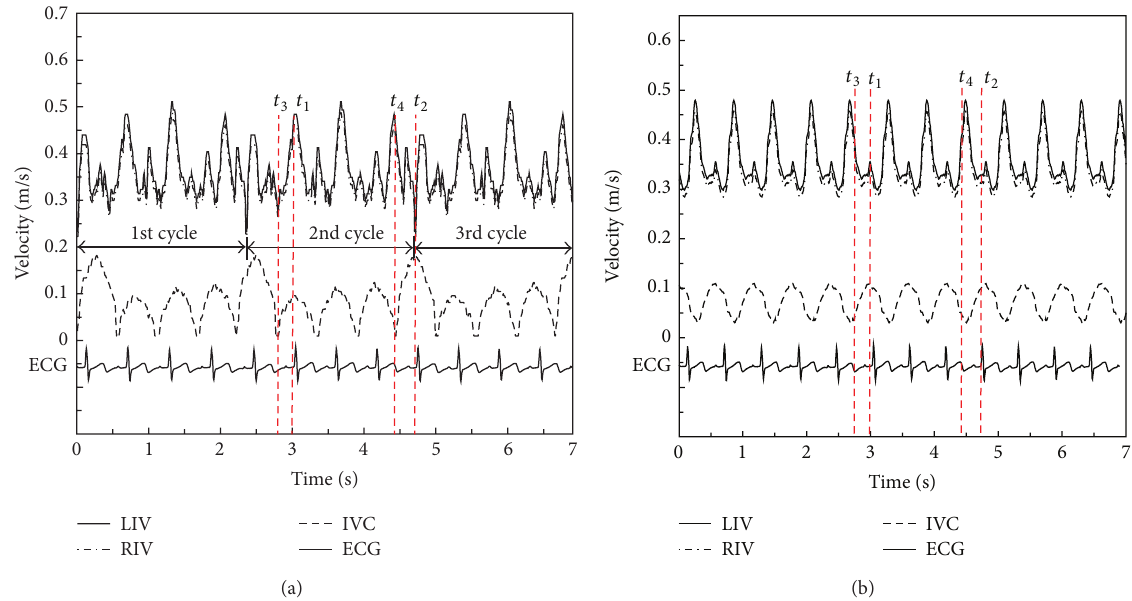
Figure6:Fourselectedtimestepsforhemodynamiccomparison( 𝑡 1 , 𝑡 2 , 𝑡 3 ,and 𝑡 4 ).(a)Inletvelocityconditionstakingrespirationintoaccount. (b) Inlet velocity conditions only including cardiac pulsatility (IVC: inferior vena cava; LIV: left innominate vein; RIV: right innominate vein; LPA: left pulmonary artery; RPA: right pulmonary artery; ECG: electrocardiogram).